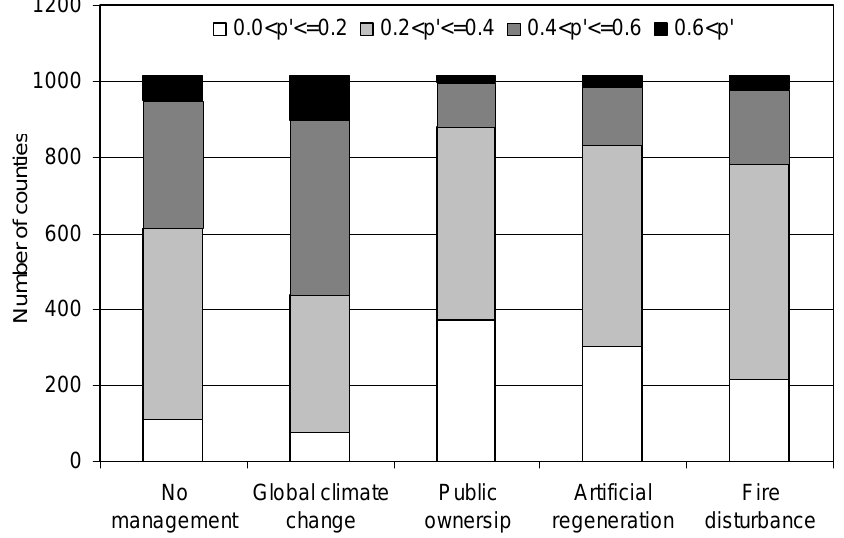
Figure 3. Number of counties within the indicated average estimated probability ( p’ ) range for invasion with no management, global climate change, conversion to public ownership, artificial regeneration, and fire